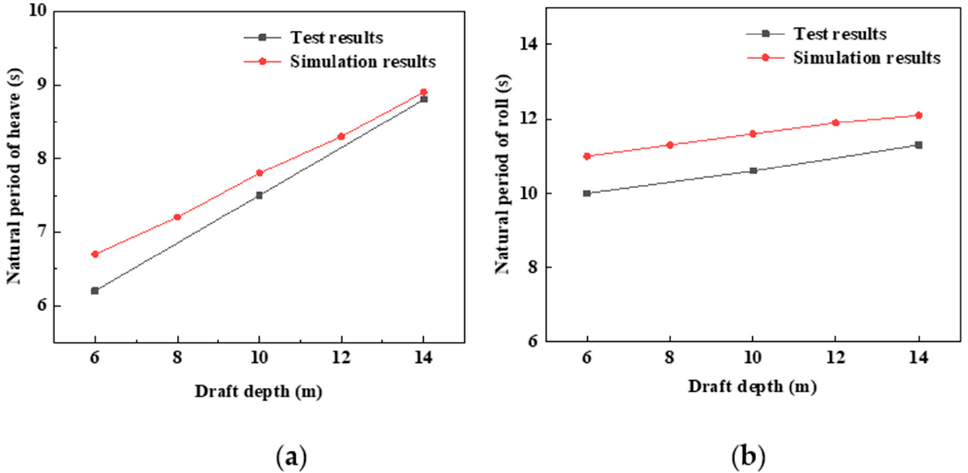
Figure 12. Comparison of test and simulation results. ( a ) Natural period of heave. ( b ) Natural period of roll.